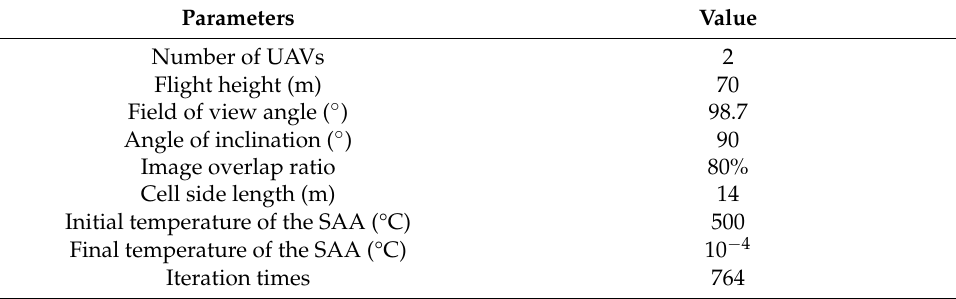
Table 1. Parameters of the experiments.